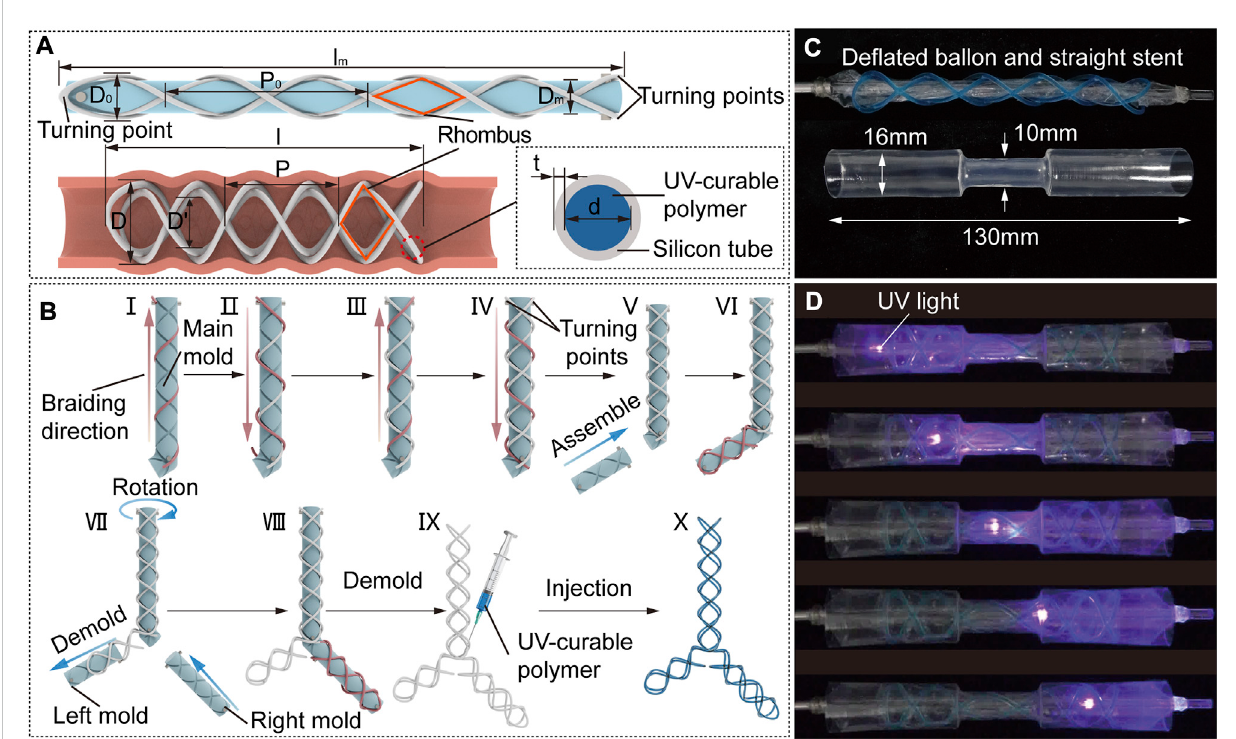
FIGURE 2 STB stent design strategy, fabrication and curing process. (A) Design parameters of an uncured STB stent on a mold (top), a cured STB stent in an airway(bottomleft),andinnerstructureoftheSTBstent(bottomright). (B) Fabricationsteps.Asiliconerubbertubeismanuallywindedalongthegrooves on the mold. Steps I to IV sequentially described the steps to wind the four helixes, and the tube highlighted in red represents the ongoing operation in these steps. Steps V to VIII separately illustrates braiding the second and the third branches of the stent. Step IX presents the injection of the UV- curable polymer. The ready-to use stent is shown instep X. (C) Initial straight stent on aballoon catheter, and aphantom trachealmodel with asimulated stricture in the middle. (D) Curing process. The uncured stent is delivered into the model across the area of the stricture. Expand the stent radially by balloon dilation to conform with the model. Cure the stent with UV light provided by an optical fi